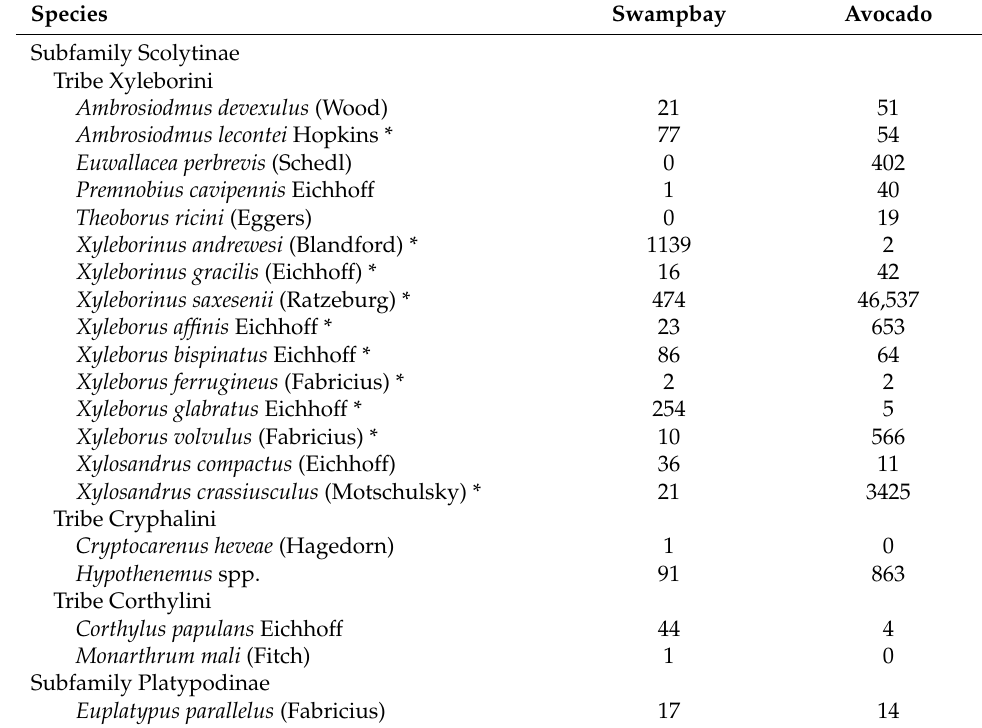
Table 1. Total captures of bark and ambrosia beetles (Coleoptera: Curculionidae) in parallel field tests at two Florida sites with laurel wilt: a swampbay forest in Highlands County and a commercial avocado grove in Miami-Dade County.